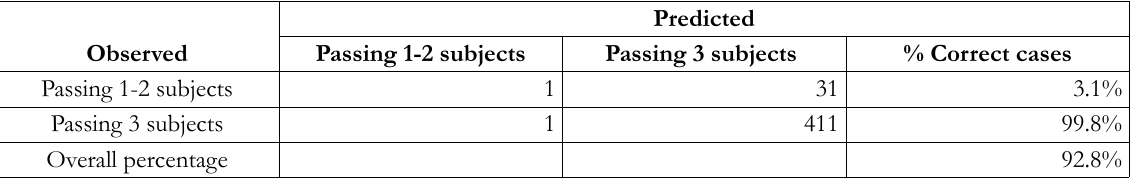
Table 6. Confusion matrix of the logistic regression model